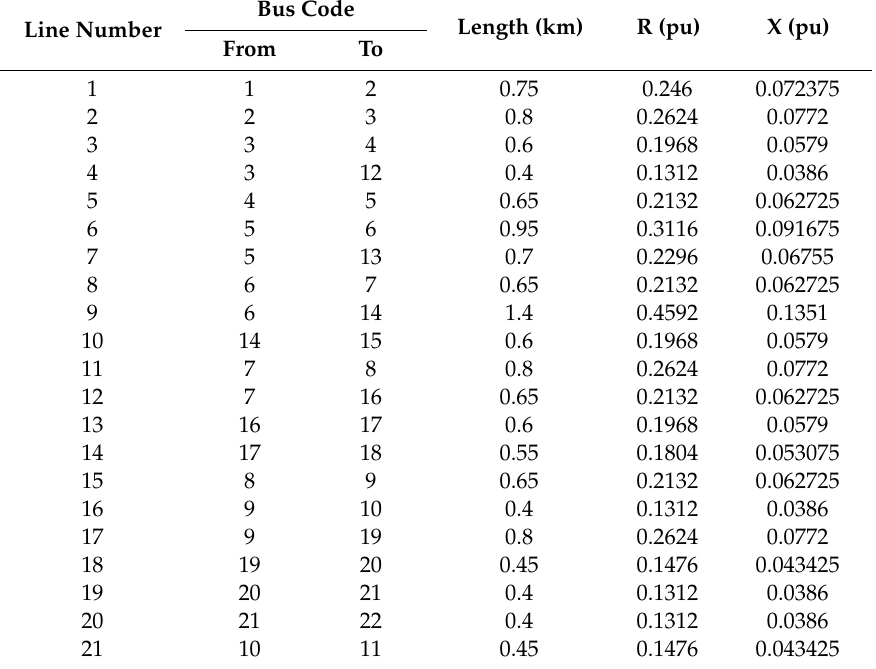
Table 1. Kabul city 20 kV distribution system transmission line